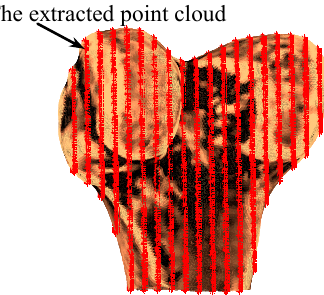
Figure 11. Diagram illustrating registration result of Knee bone model and the extracted point cloud.